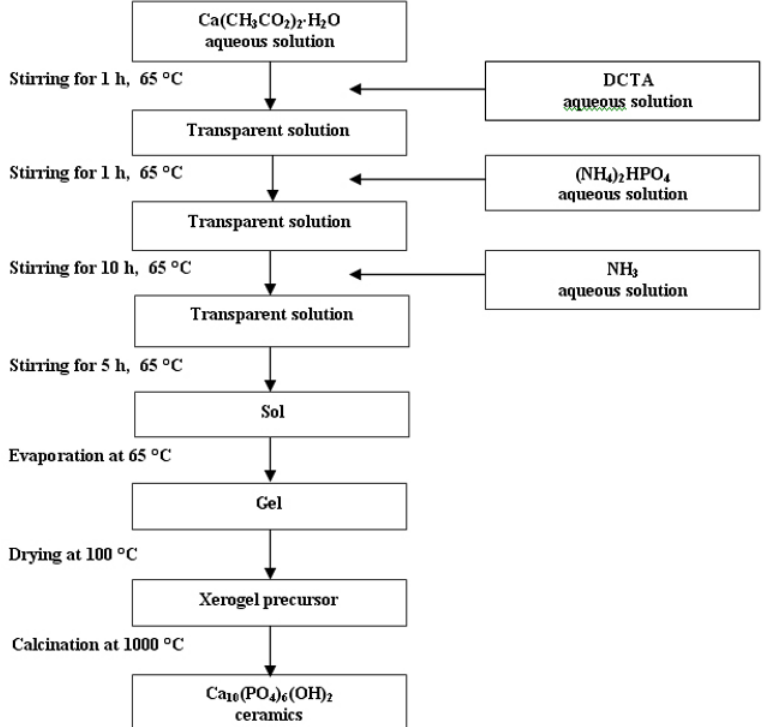
Figure 1. A schematic diagram of the steps involved in the sol-gel processes used for the preparation of Ca